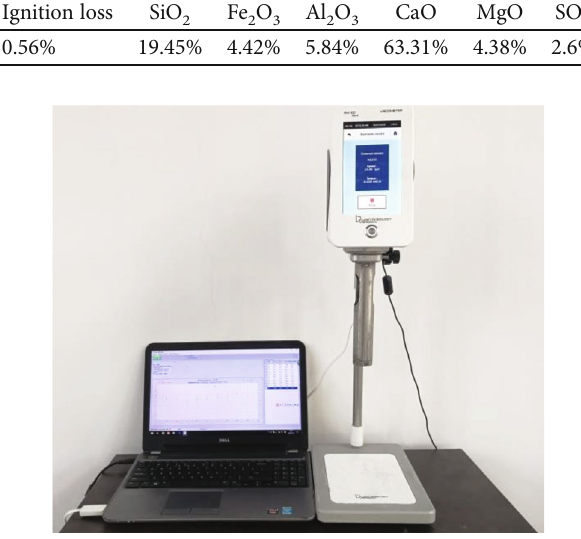
Figure 2: Lamy RM100 touch-type rheometer.